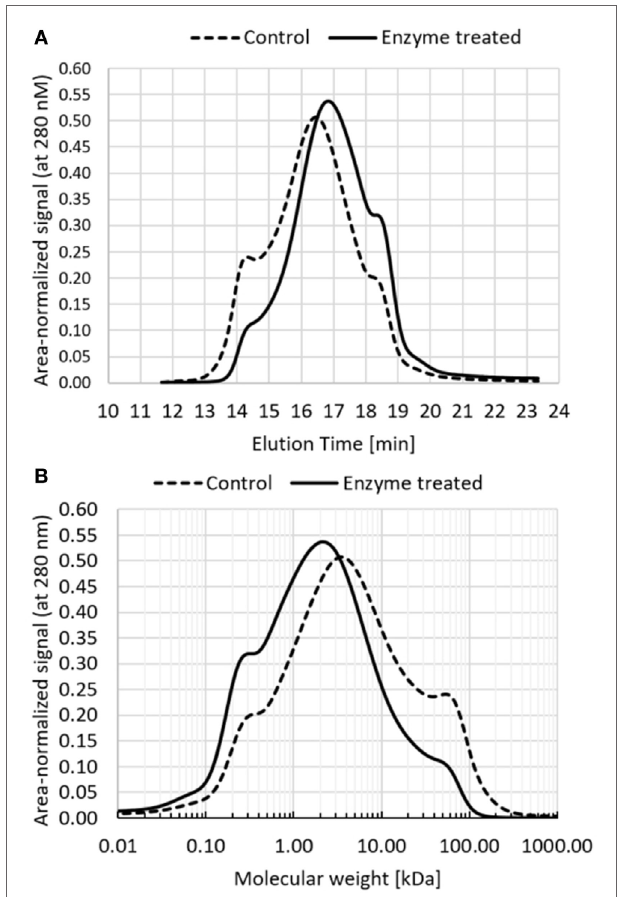
FigUre 2 | Molecular weight distribution of enzyme-treated lignin sample and control sample (the same process run without the enzyme). (a) Elution profiles of size exclusion chromatography, profiles were area-normalized to reflect the same total mass; (B) molecular weight distribution calculated based on HPLC profile using molecular weight